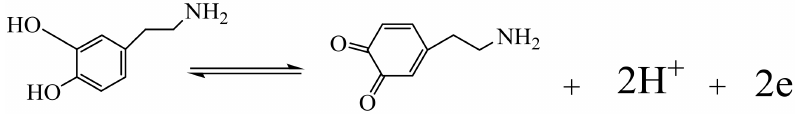
Figure 8. Scheme of electrochemical redox mechanism of